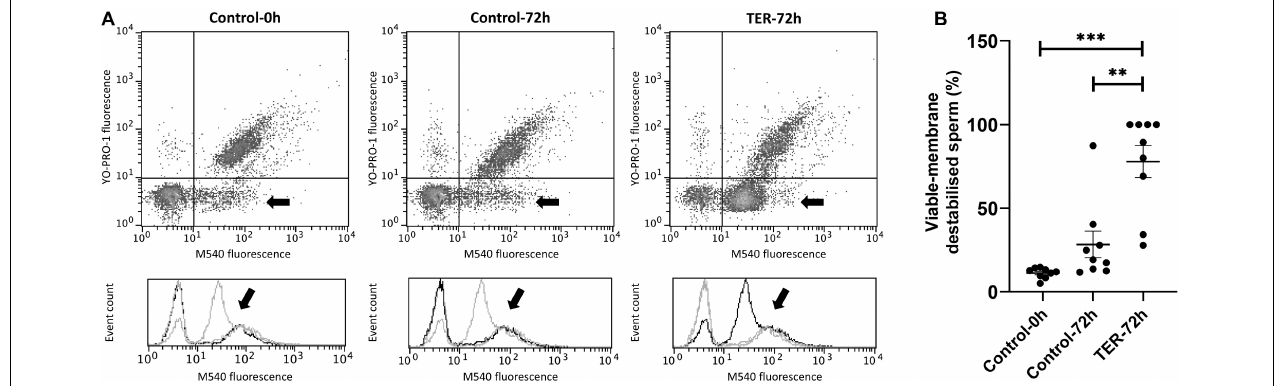
FIGURE 7 | Flow cytometry analysis of plasma sperm membrane stability. (A) Representative flow cytometry dot plots of Yo-Pro-1 and merocyanine (M540) fluorescence and histograms showing the event count of M540 fluorescence intensity of all treatments. Black arrows show the flow cytometry population selected for analysis represented in (B) . Dark gray lines in histograms show the event count of its corresponding treatment, whereas light gray lines show the event count of the remaining treatments. (B) Mean, standard error of the mean (SEM), and sample distribution of the percentage of membrane-destabilized cells within the total viable sperm population in all treatments. Control-0h, semen samples at 0 h of storage; Control-72h, vehicle control (dimethyl sulfoxide; DMSO) semen samples at 72 h of storage at 17 ◦ C; TER-72h, semen samples treated with 100 µ M ezatiostat (TER) for 72 h of storage at 17 ◦ C. Sample size ( n = 9). ** p ≤ 0.01; *** p ≤ 0.001.